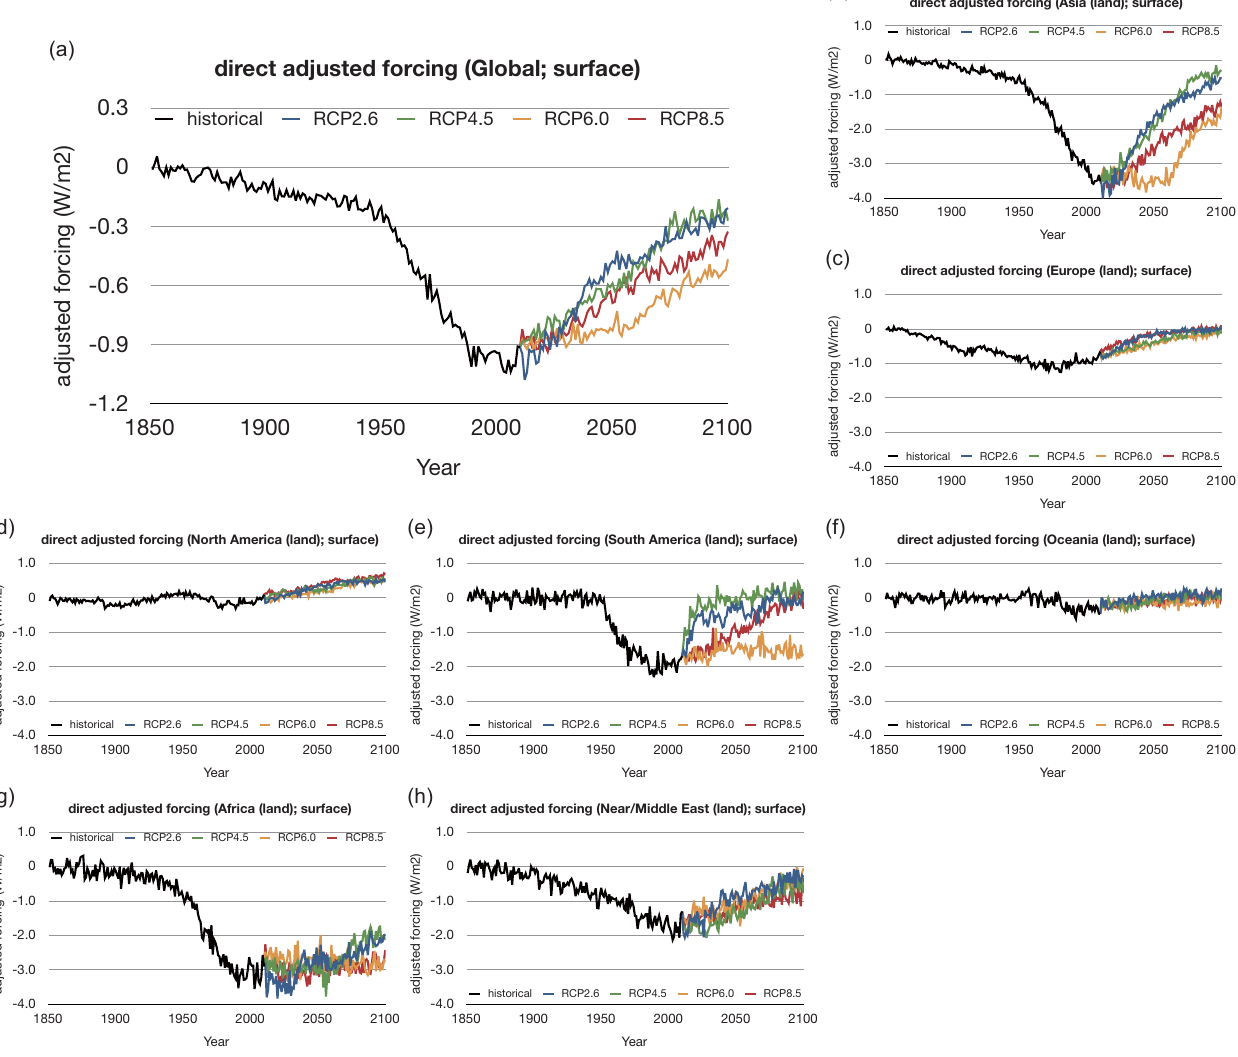
Fig. 9. Time series of annual and (a) global or (b) – (h) regional mean adjusted forcing due to the aerosol direct effect at the surface relative to the preindustrial experiment simulated by SPRINTARS. The regional mean values are only over land. The historical period is shown in black, and the four RCPs are shown in